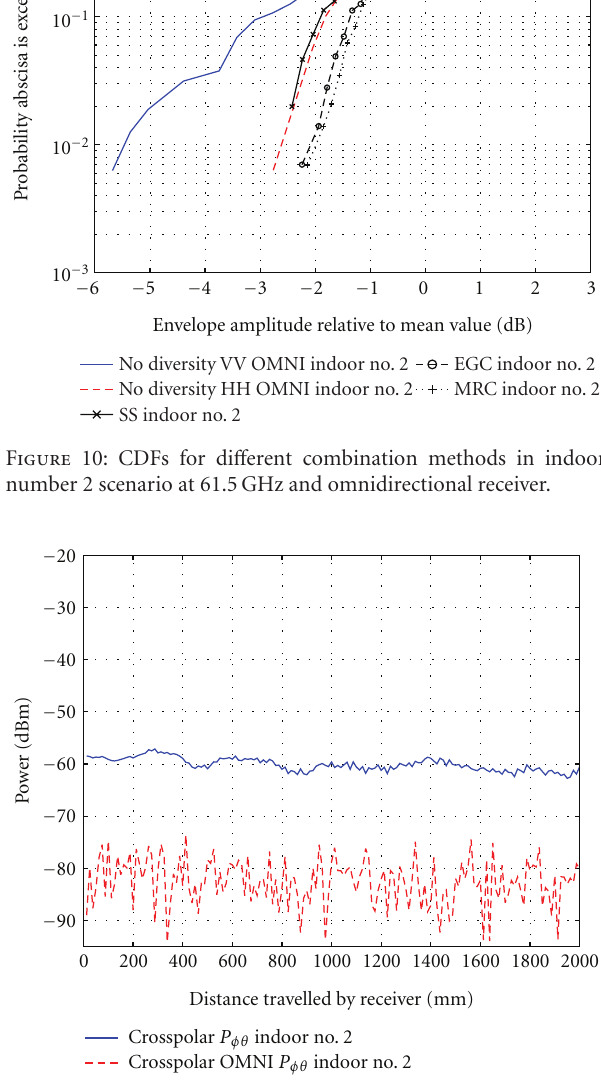
Figure 11: Power variation against distance of the cross-polar received signal envelope in indoor number 2 at 61.5